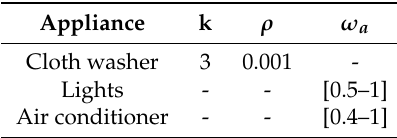
Table 6. Discomfort